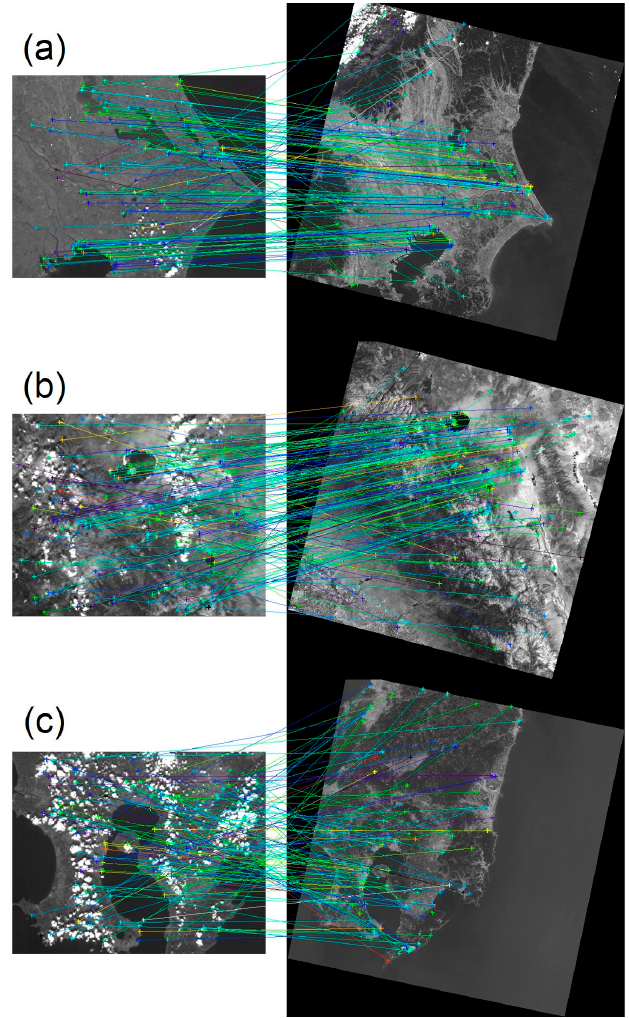
Figure 4. Examples of feature extraction and rough matching by the SURF algorithm in: ( a ) a less cloudy case (Kanto, Japan); ( b ) a moderately cloudy case (Yosemite, US); and ( c ) a case with many cloud patches (Kyushu, Japan) in the VIS images. Left and right panels are satellite images from UNIFORM-1 and base maps from Landsat-8, respectively. The “+” signs represent the locations of detected SURF features, and the lines connects pairs of corresponding features in the two images. Line color represents the relative similarity of the paired features (blue to red in order of increasing similarity), measured as the distance of SURF descriptors between the paired features.